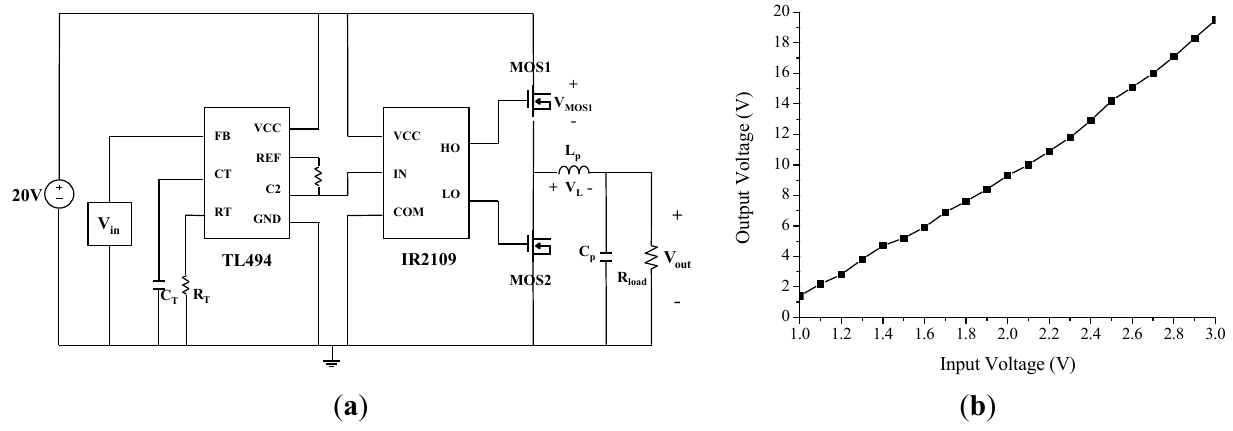
Figure 5. Circuit implementation of DC–DC converter. ( a ) Schematic of DC–DC converter. ( b ) Measurement